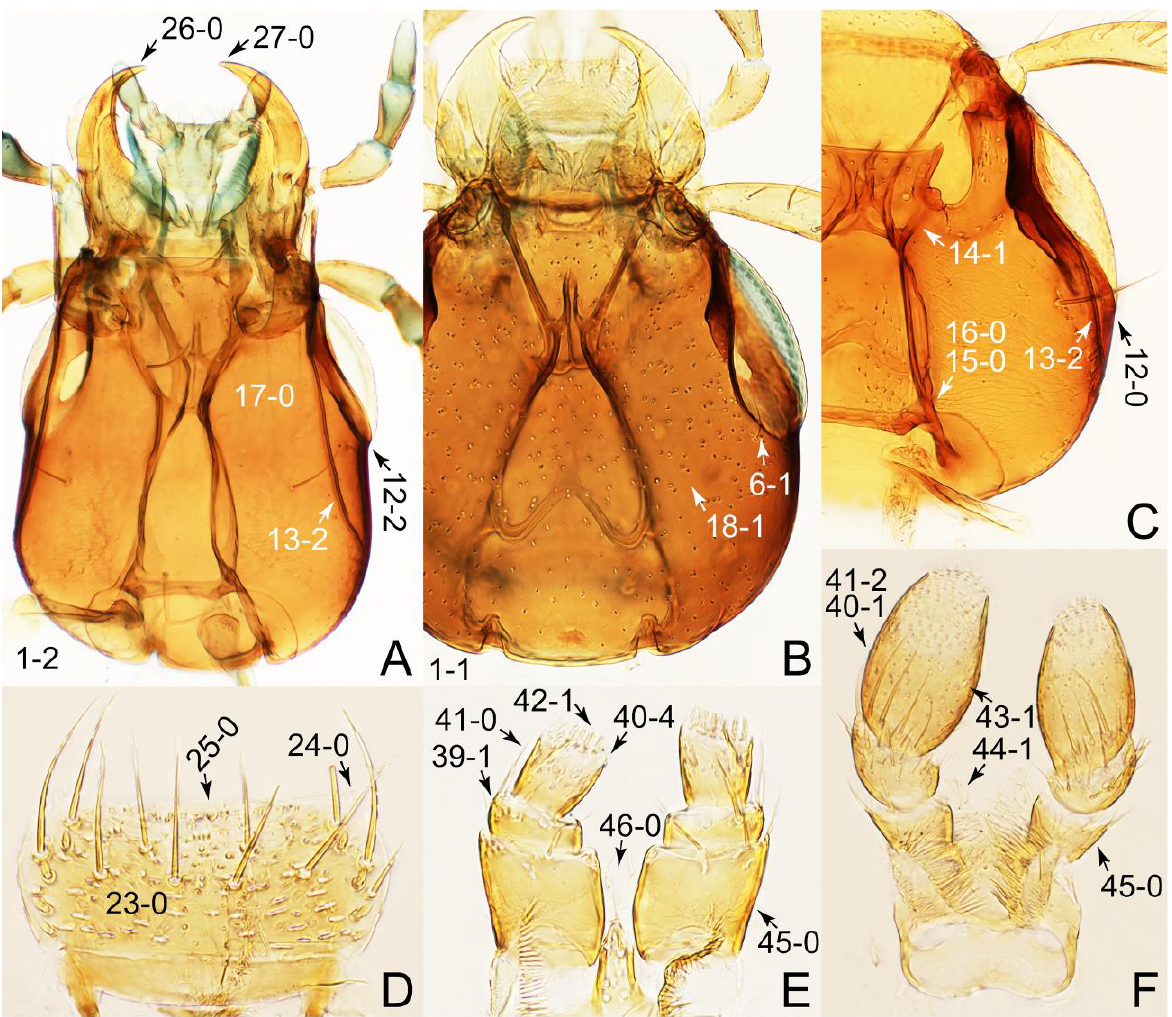
dominal segments IX and X): tergite IX (Figure 72A–C) continuous dorsally in basal half (Figure 72A,B: 120-2, 121-2), basally separated by sternite IX (Figure 72C: 119-0), with ventral struts (Figure 72C: 118-1). Male genitalia: aedeagus (Figures 66C and 72D–F) with parameres simple, widely separated from each other and from median lobe (Figure 72F: 142-0, 143-0), with rows of parameral setae (Figure 72D,E: 147-1, 147-2); internal sac without prominent spines (Figure 72E: 141-0). Female genital segments (Figure 73A,B,D: 139-1) moderately to strongly elongate; basal area of tergite IX well sclerotized (Figure 73B: 140-0). Female genitalia: gonocoxites (Figure 73A,B,D) present, distinct and large, well sclerotized; gonocoxite II thick, narrowly elongate (Figure 73A: 153-2), well-sclerotized, much larger than gonostylus (Figure 73A: 154-1), usually covered with normal, non-curved setae (see Figure 73B: 155-0); gonostylus (Figure 73A,B,D) minute, inconspicuous (Figure 73D: 156-1), with apical seta.